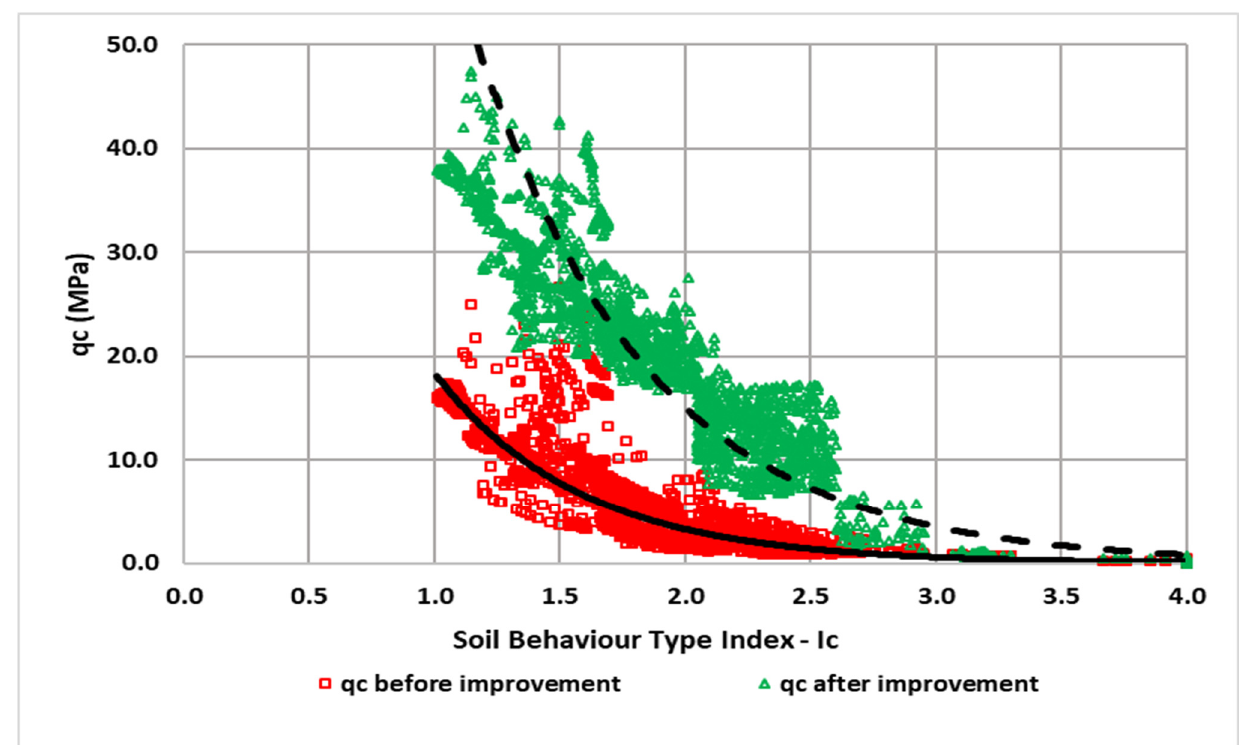
Figure 2. pre and post improvement qc vs. I c .